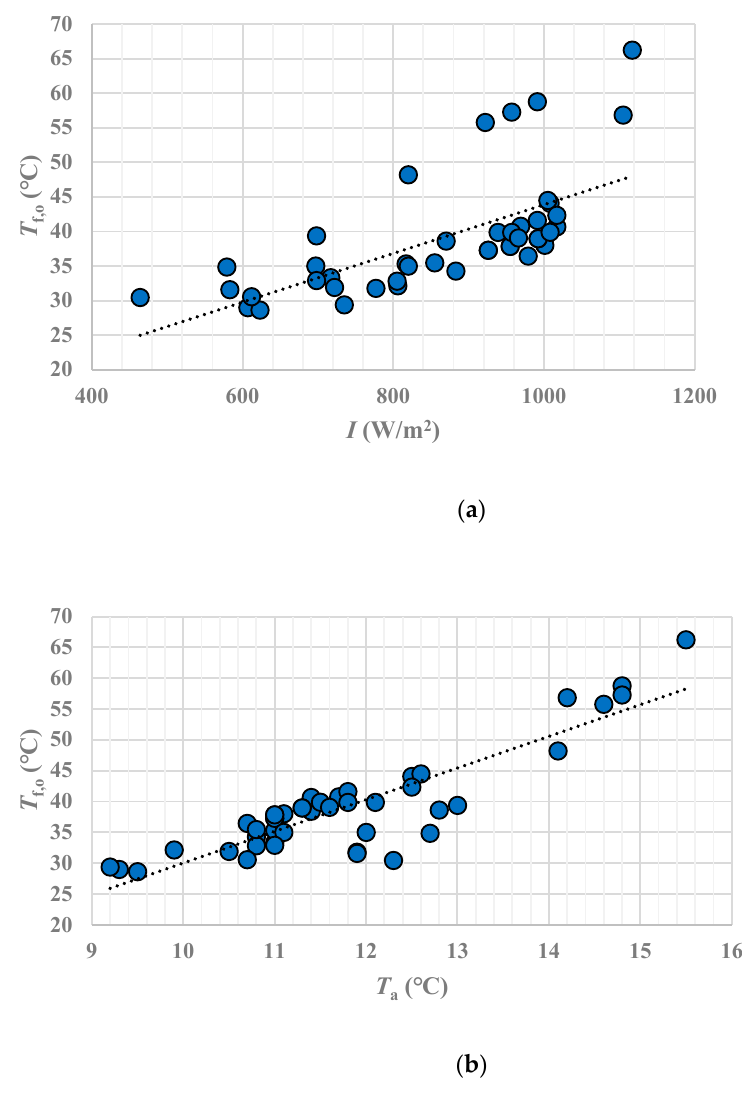
Figure 12. Dependence between collector performance and ambient conditions. ( a ) Dependence between T f,o , and I. ( b ) Dependence between T f,o, and T a .